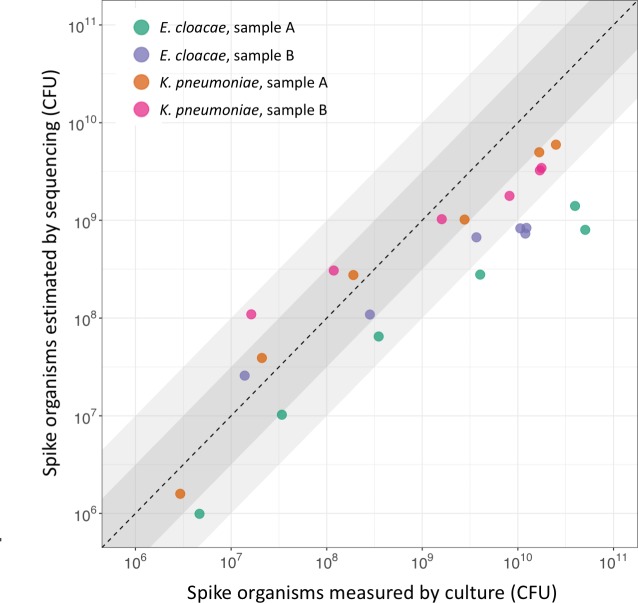
Comparison of CPE organisms estimated by sequencing and culture.Number of spike organisms estimated by sequencing compared to measurement by culture. Samples enriched in broth containing cefpodoxime, vancomycin, and metronidazole. Two spike organisms (K. pneumoniae & E. cloacae) and two volunteer samples (A & B) used. Points represent the geometric means of 2 replicates, shaded areas are within 0.5 and 1.0 log10 of the line of identity.